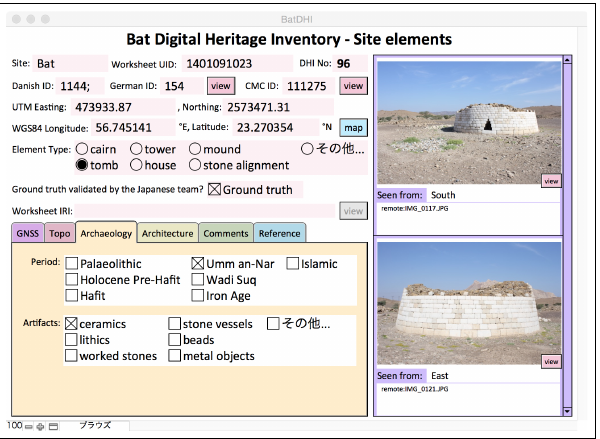
Figure 6: Interface of the ElementDHI table (Archaeology tab). Figure 7: Interface of the ElementDHI table (Architecture